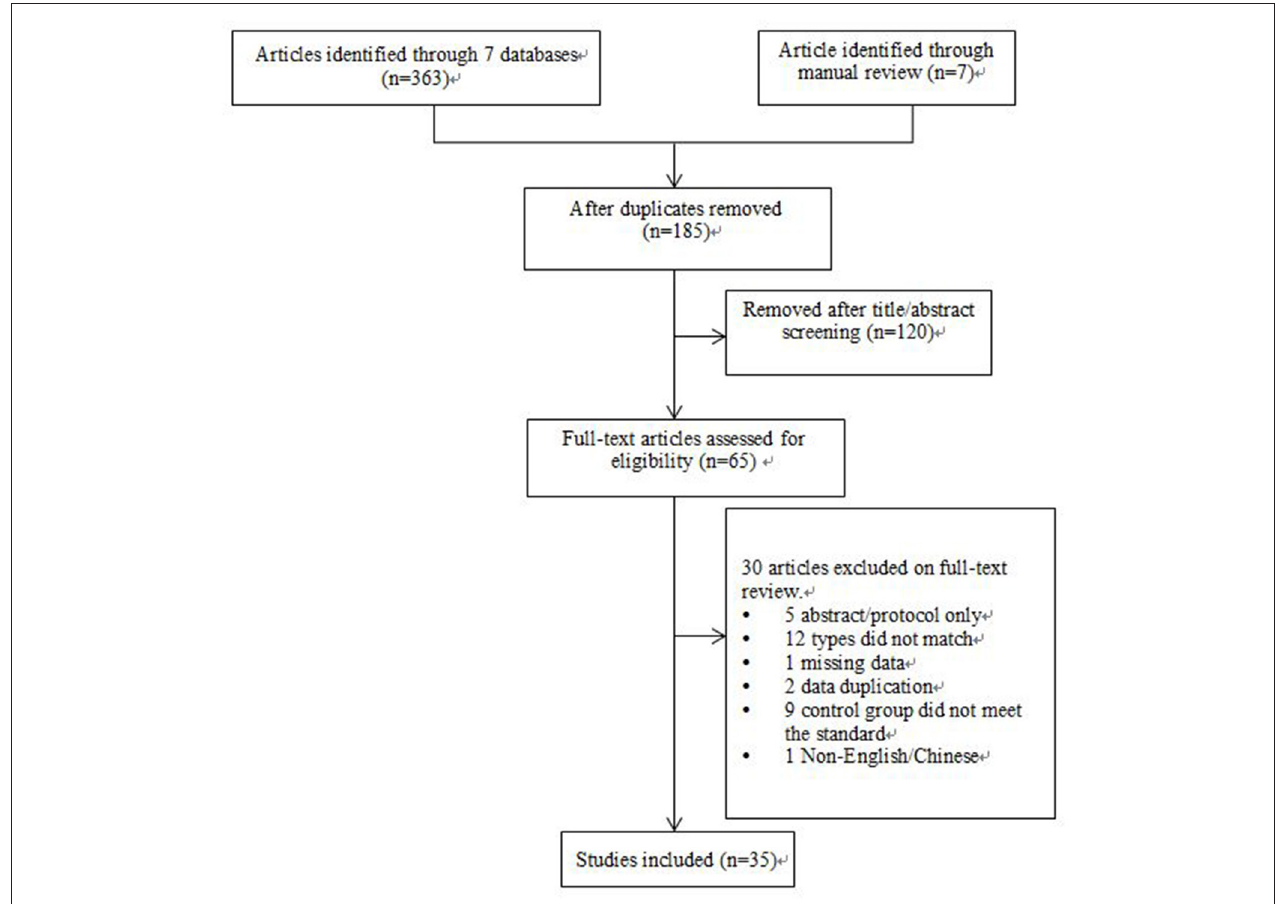
FIGURE 1 | Flow diagram of article selection for inclusion according to the PRISMA guidelines.